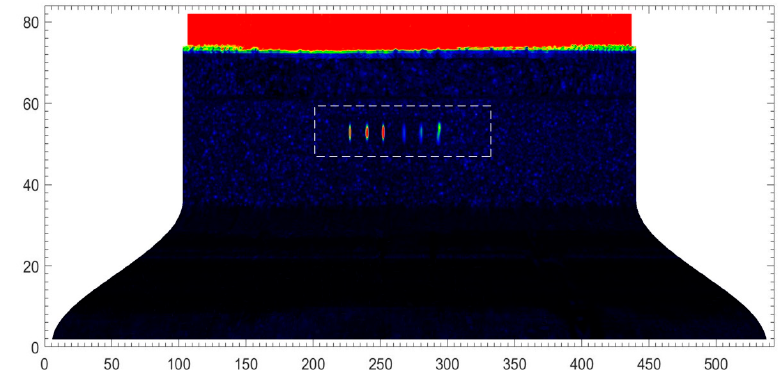
Figure 11. A C-scan image of longitudinal cracks when the water path was 21.27 mm in length.